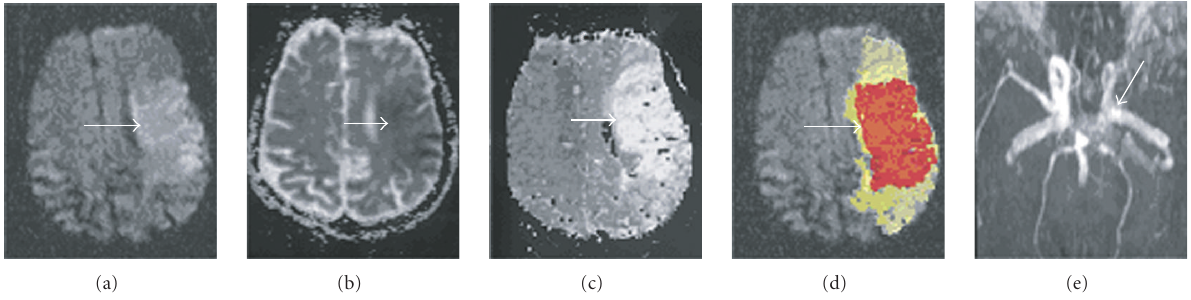
Figure 5: A 55-year-old female, brainstem infarction in hyperacute stage (6 hours). The images are DWI (a), ADC map (b), MTT map (c), penumbra map (d) and MRA (e), respectively. The abnormal signal was located in left frontal lobe, which showed hyperintense signal in DWI, and hypointense signal in ADC map. In MTT map, the hyperintense signal was also seen and the abnormal region seemed larger than that in DWI. The mismatch of DWI and PWI was then processed and the penumbra map was obtained (the red part implied the infarction part and yellow one meant penumbra). MRA showed that there was a signal loss in the left cerebral middle artery.